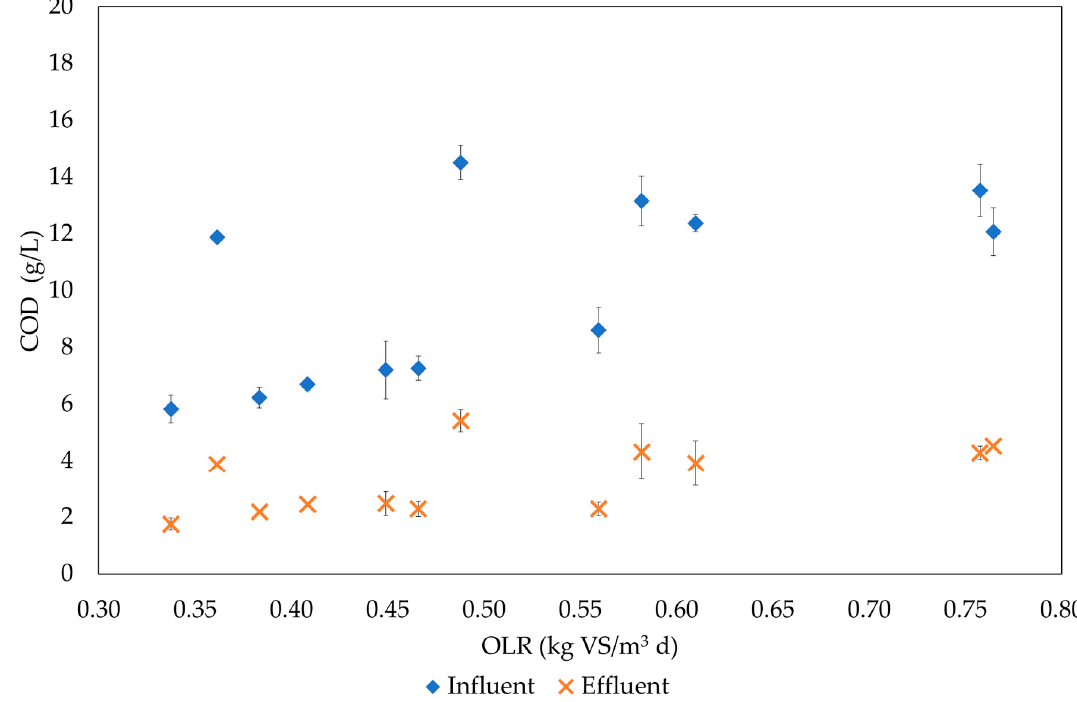
Figure 4. Chemical oxygen demand concentration for influent (blue rhombuses) and effluent (orange cruxes) during OLR changes.